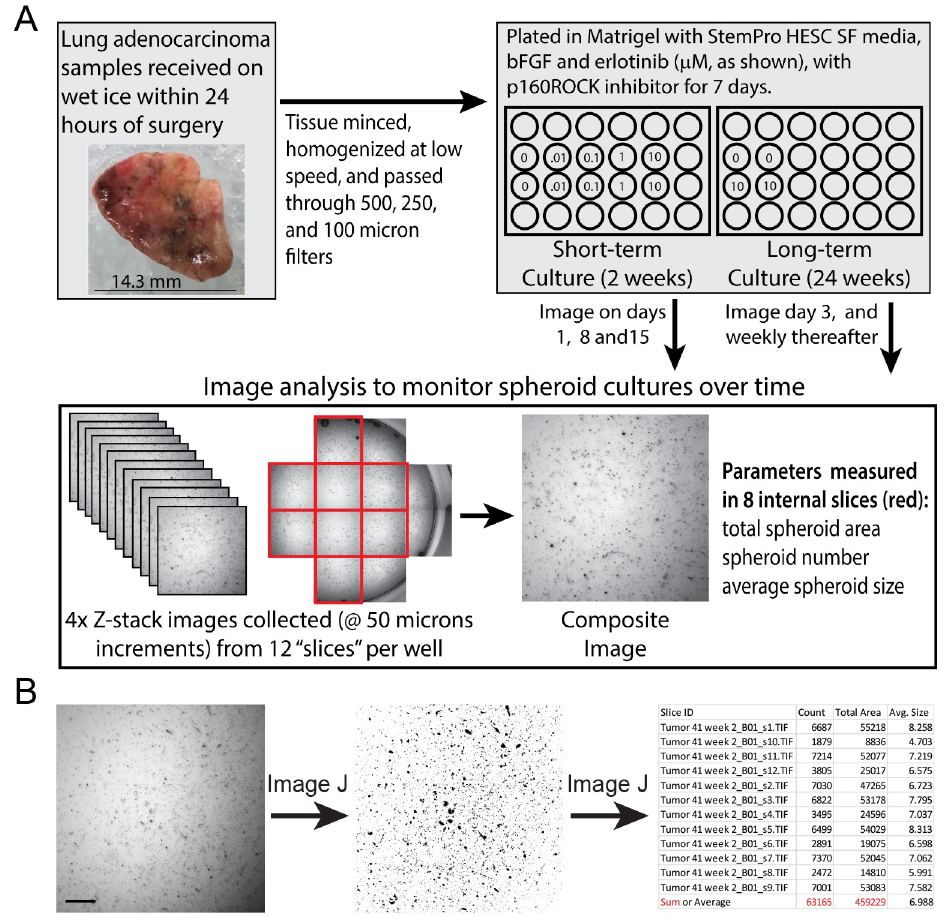
Fig 1. Processing, culture and image analysis of primary lung tumor spheroids. Short- and long-term cultures were plated in Matrigel, and Z-stack images were collected approximately weekly as shown (A). Eight composite images from each well were analyzed using an Image J analyze particle macro to quantify total spheroid area, spheroid number, and average spheroid size (B). The scale bar in (B) is 500 μ m.